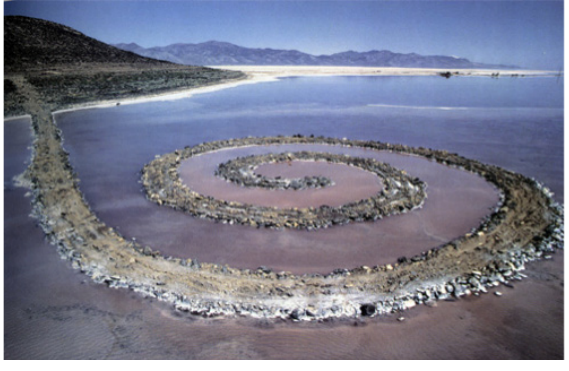
FIGURE 3 | Robert Smithson, Spiral Jetty, 1970, Rozel Point, Utah, USA.